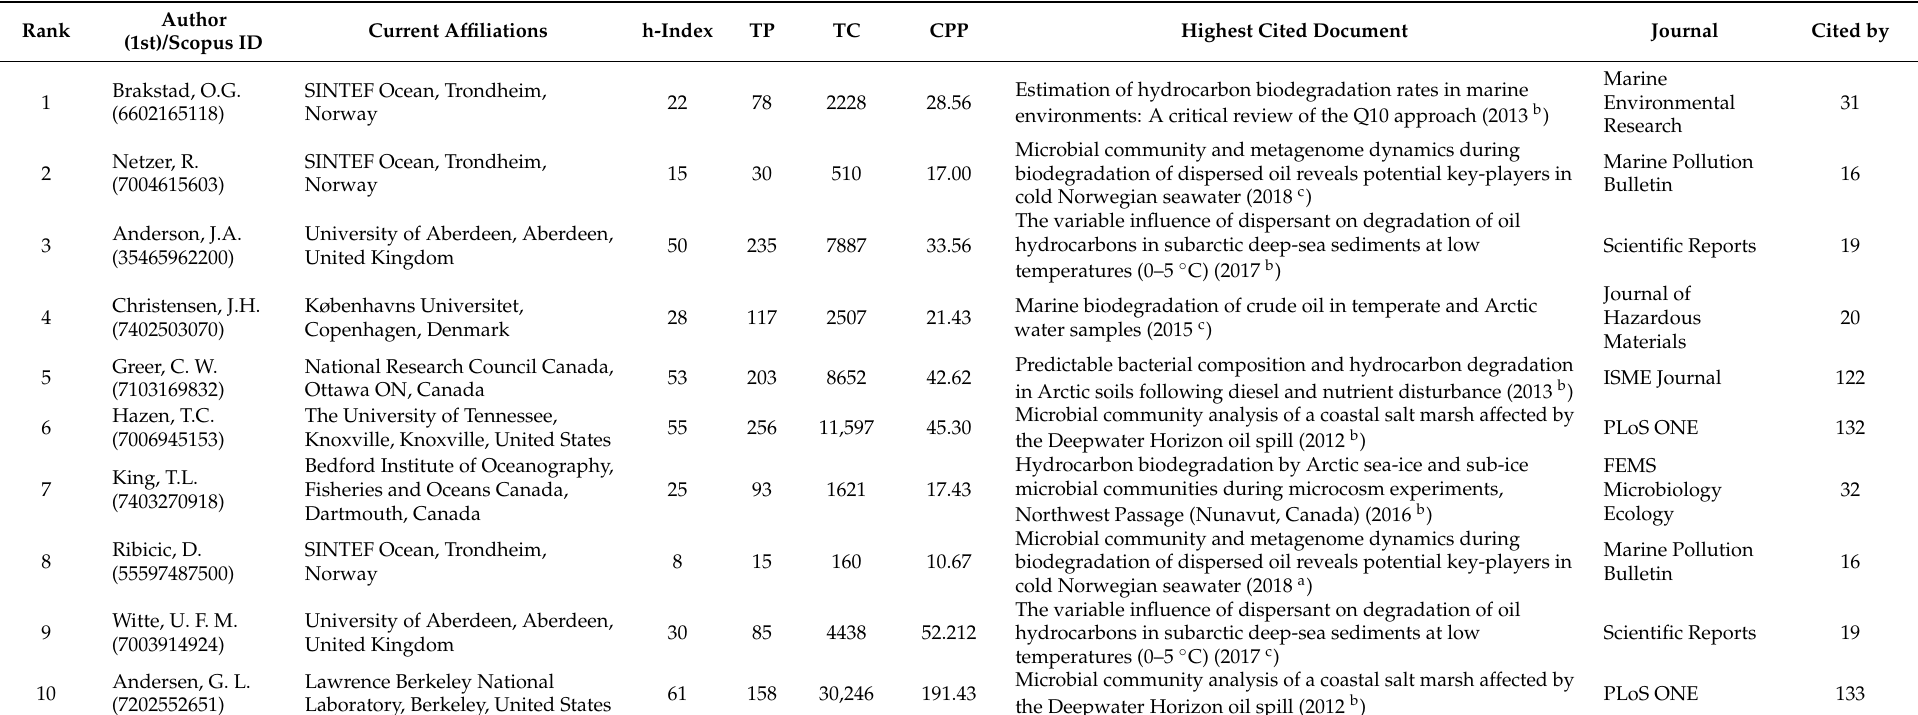
Table 4. Most productive 10 authors that published journal articles between 2009 to 2019 related to degradation of hydrocarbons in the Arctic marine environment by microbial